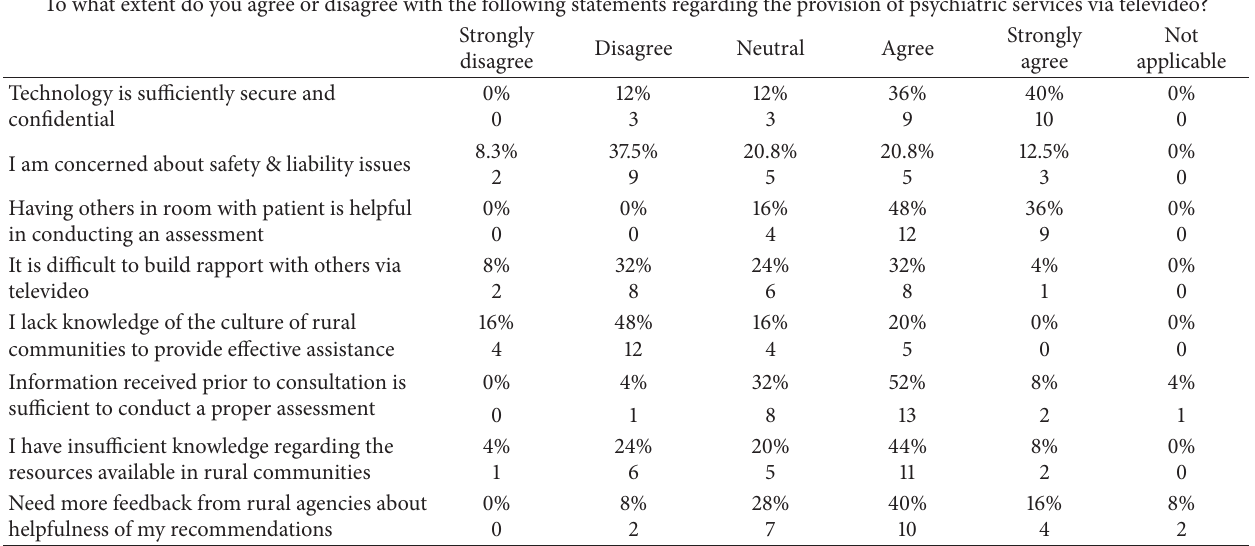
Table 5: Psychiatric services via televideo ( 𝑛 = 25 ).